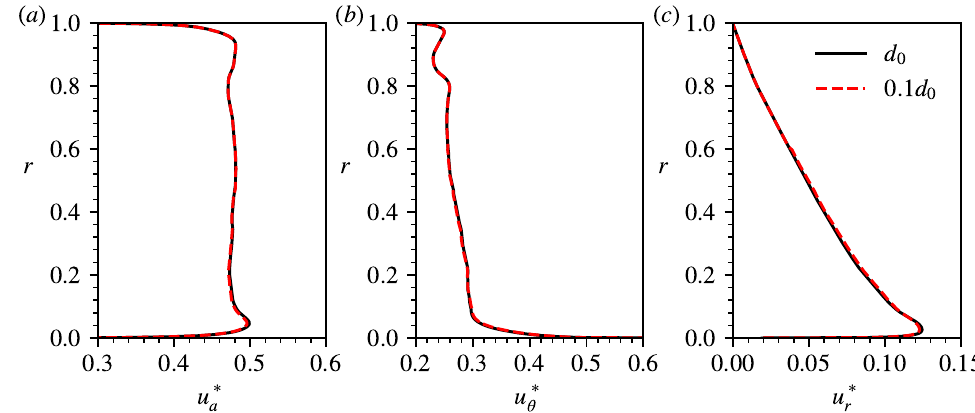
Figure 19. Spanwise distributions of the three velocity components on the rotor outlet at different stage gaps: ( a ) axial; ( b ) circumferential; ( c ) radial.